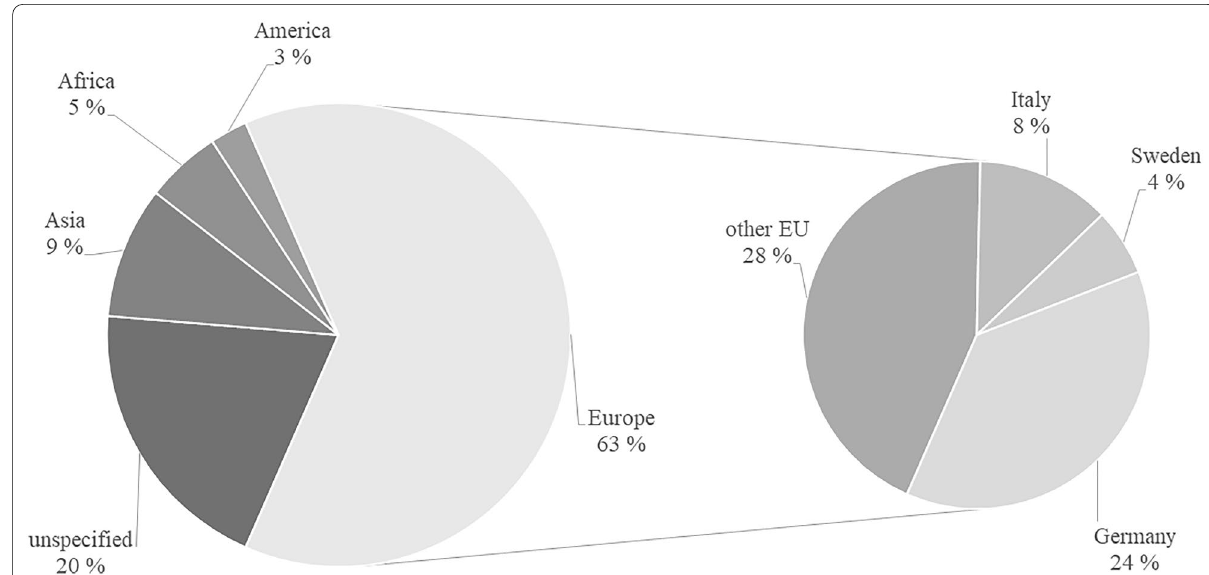
Fig.2 Distribution of papers by countries and regions considered